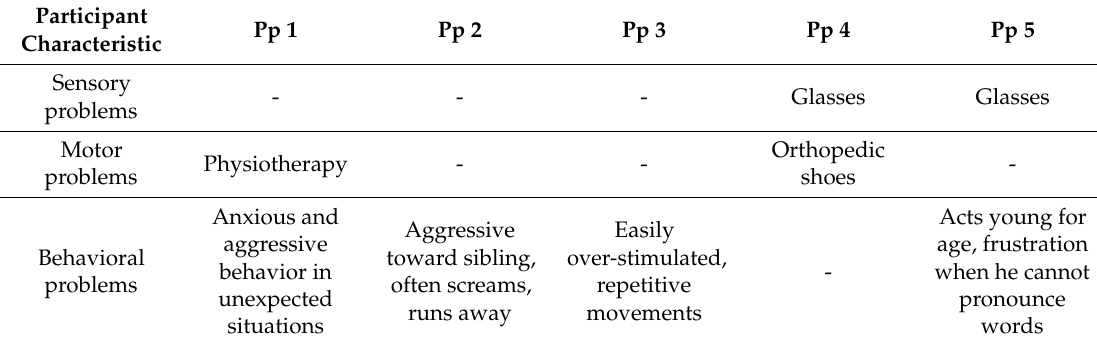
Table 2. Participant